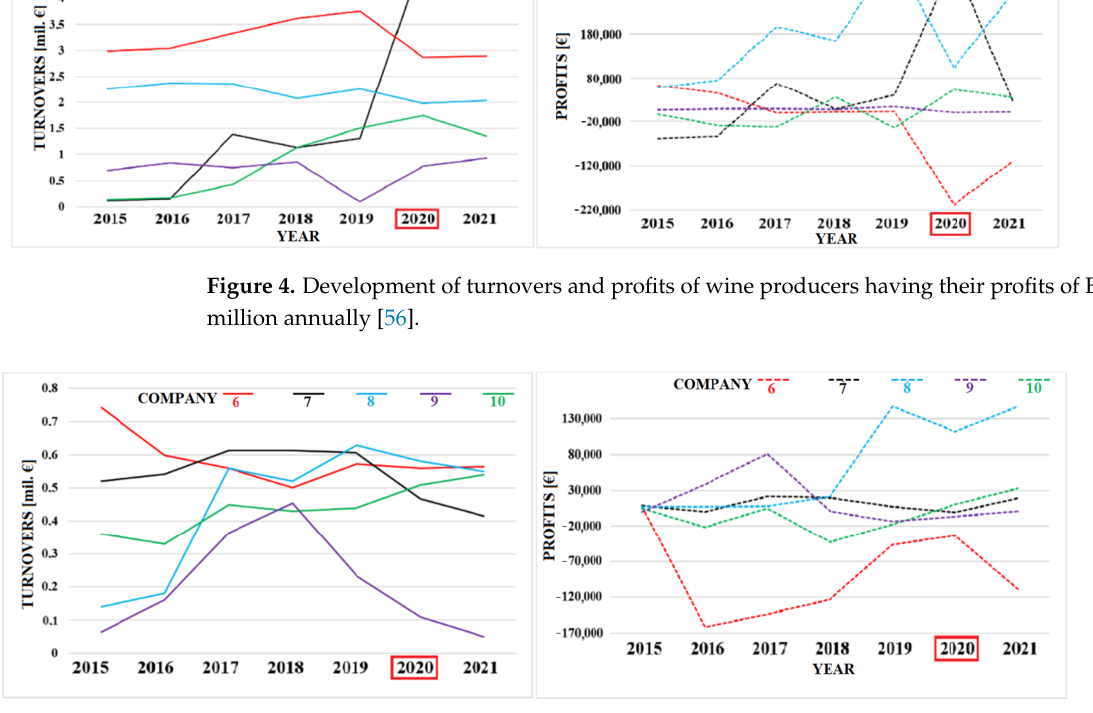
Figure 5. Development of turnovers and profits of the wine companies with turnovers of EUR 0.05 to 0.75 million annually [56].